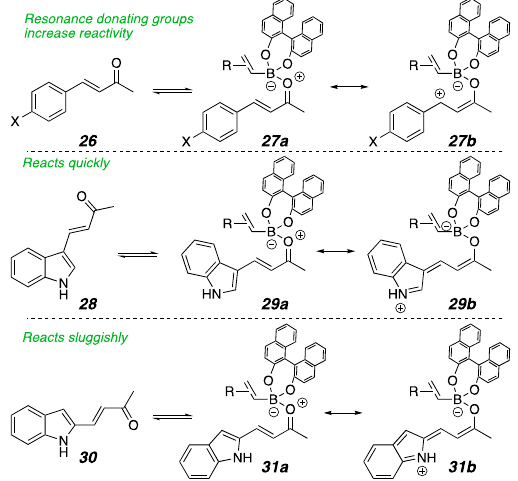
Figure 6. Stabilization of the zwitterionic intermediate.